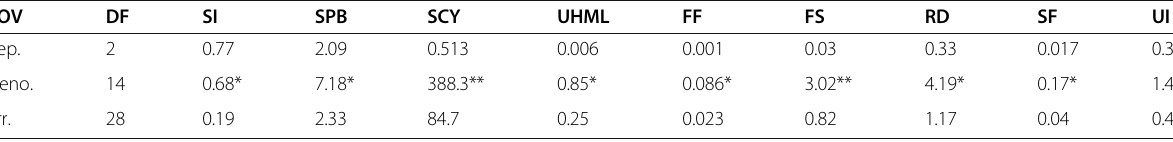
Table 3 Mean squares for yield and fiber quality-related traits in G. hirsutum genotypes SOV DF SI SPB SCY UHML FS RD SF UI